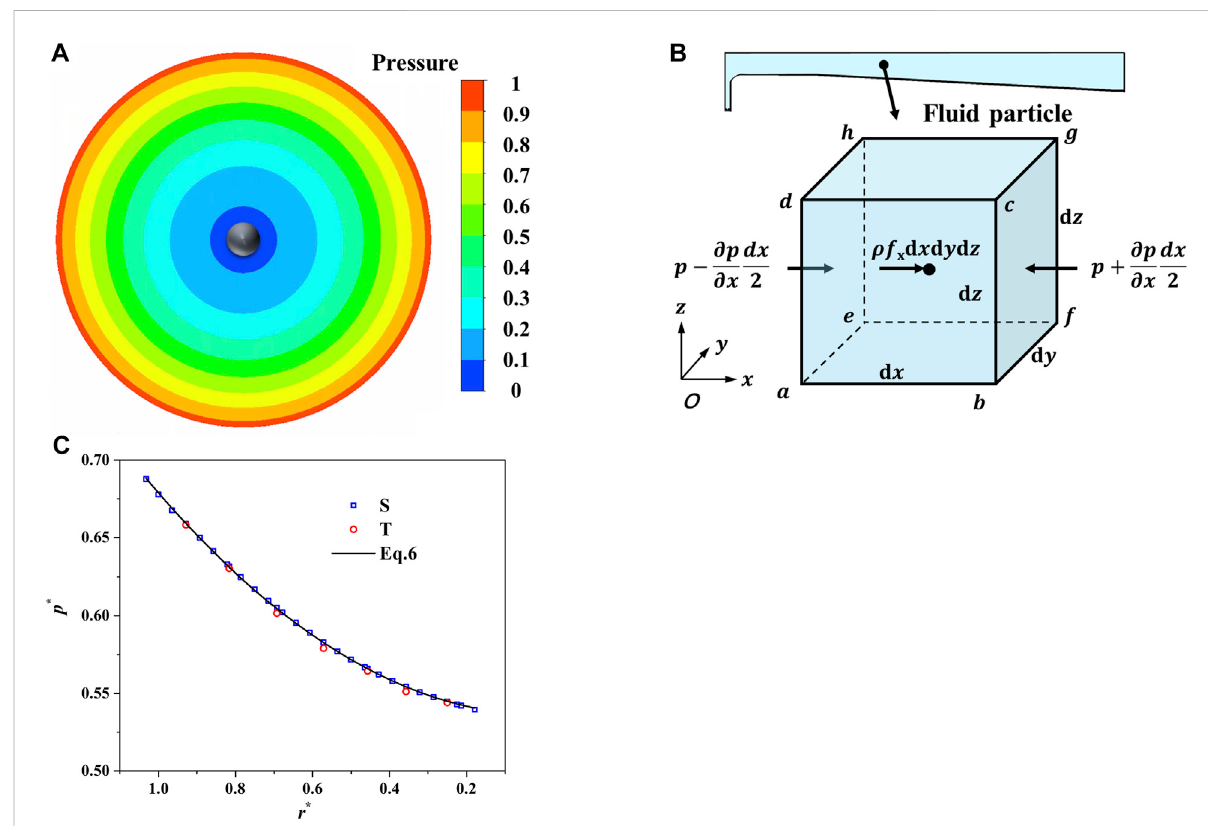
FIGURE 8 Pressure distributions ( ω 0 =200 rpm and h 0 = 40 mm). (A) Pressure contours in the 0 . 45 h 0 cross-section. (B) Fluid force diagram (Hou et al., 2021b). (C) Pressure distribution along the radial